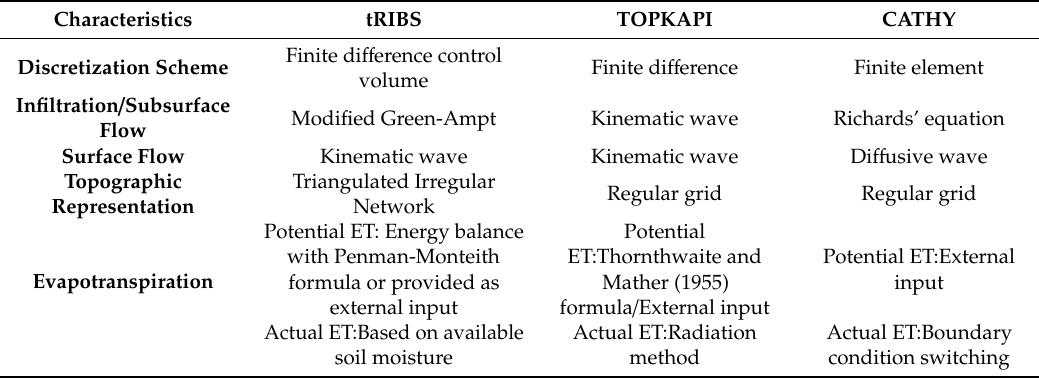
Table 2. Summary of structure and characteristics of the three hydrologic